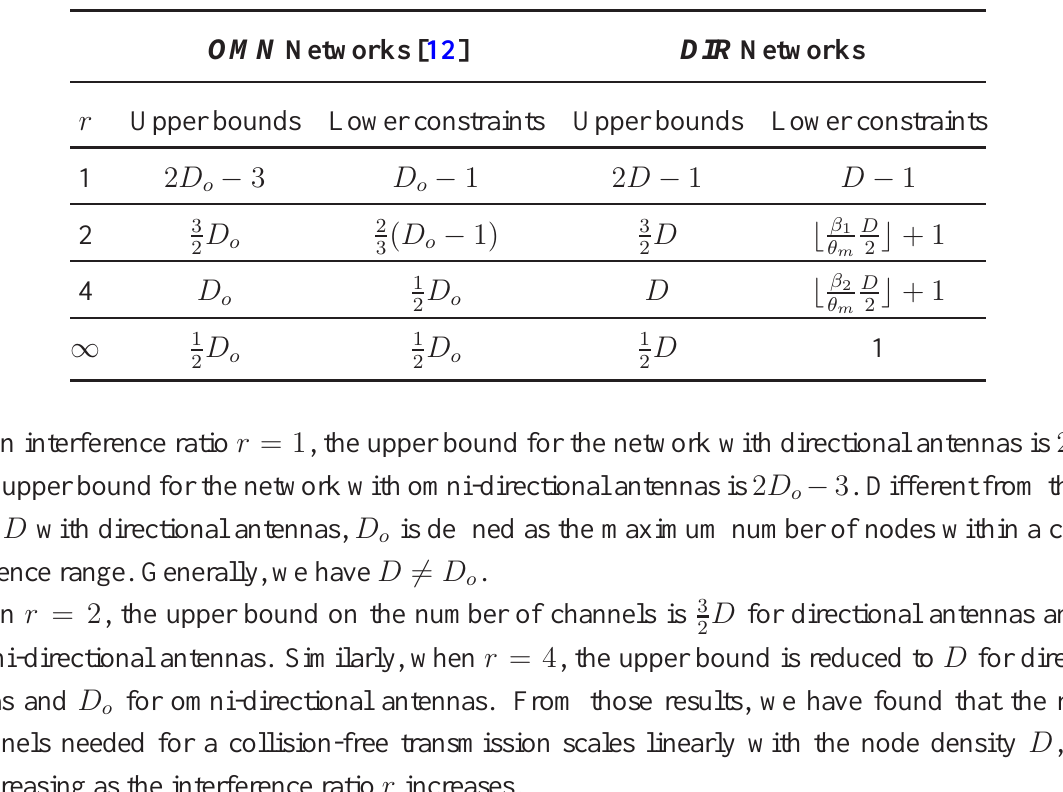
Table 1. Comparisons of OMN networks and DIR